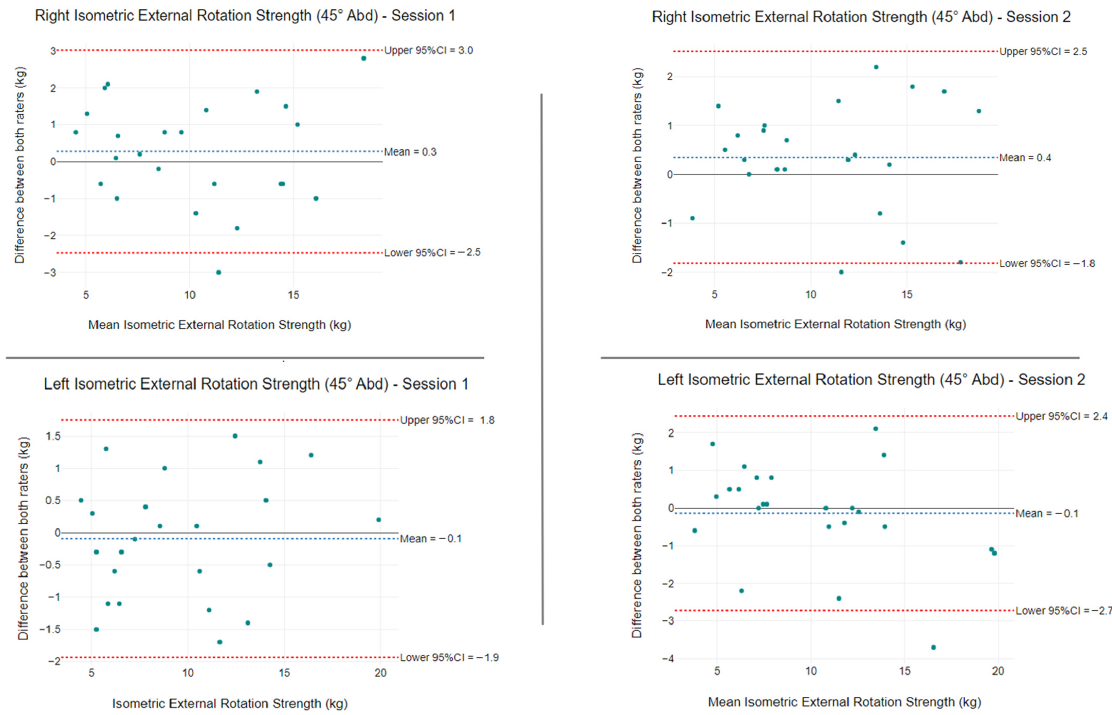
Figure 8. Isometric shoulder ER strength at 45° of abduction differences between raters using a HHD and stabilisation device) for left and right. The blue segmented line is the mean difference between raters, and the segmented red lines show the 95% limits of agreement. The mean HBB differences between raters were − 1.6 cm and − 2.1 cm in session one and − 2.3 cm and − 1.6 cm in session two. All ROM values were distributed sparsely and not strongly concentrated along the horizontal axis (Figure 6).